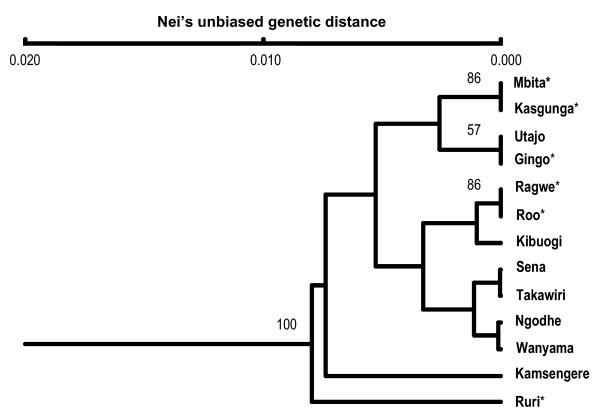
A UPGMA tree based on Nei's unbiased distance showing genetic divergence among Anopheles gambiae populations. The numbers above branches indicate those with >50% bootstrap support. The populations marked with an asterisk are the mainland populations.